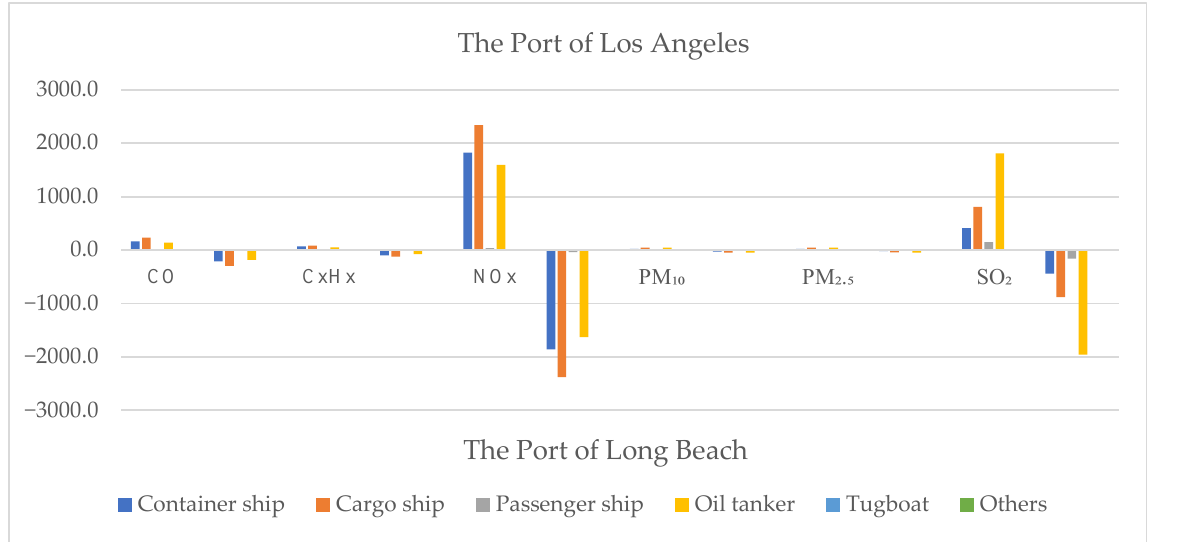
Figure 9. Comparison of pollutant emissions from different ship types in different ports (unit: ton).